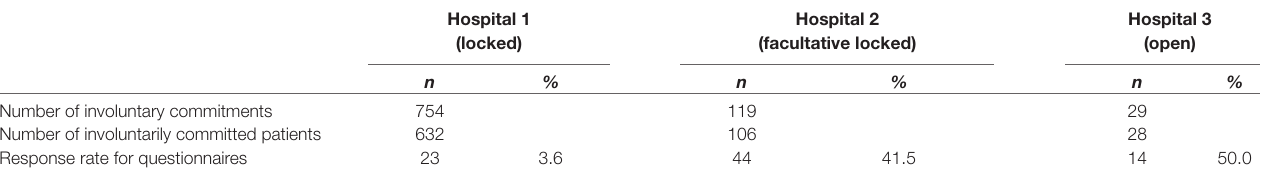
TABLE 1 | Involuntary commitments and response rate per